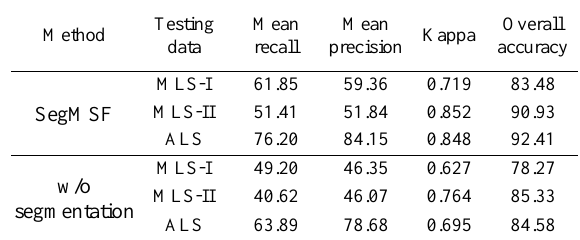
Table 3. Classification results of test data with the proposed